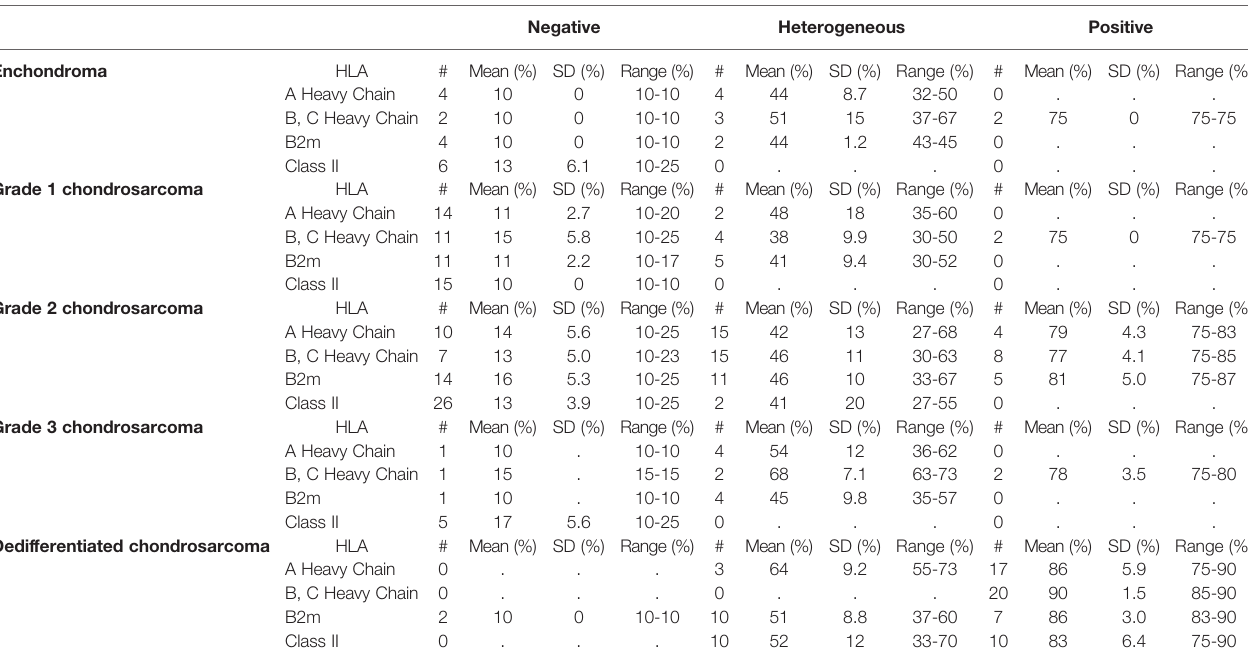
TABLE 2 | HLA class I subunit and HLA class II antigen expression in benign and malignant cartilage tumors.